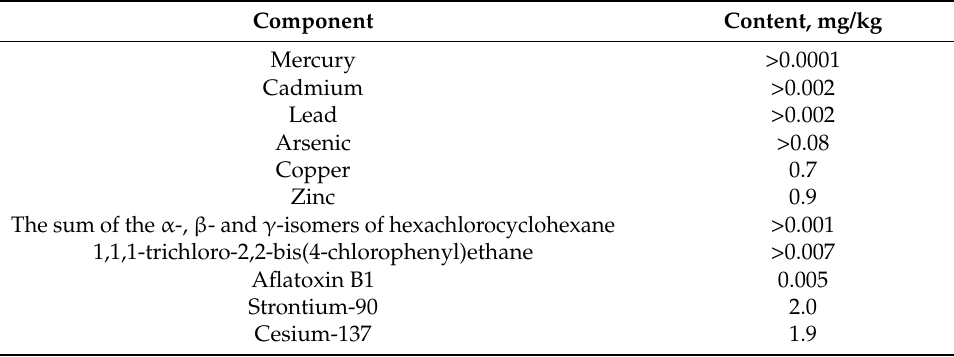
Table 5. The content of toxic elements in Dactylorhiza maculata extracts. Component Content, mg/kg